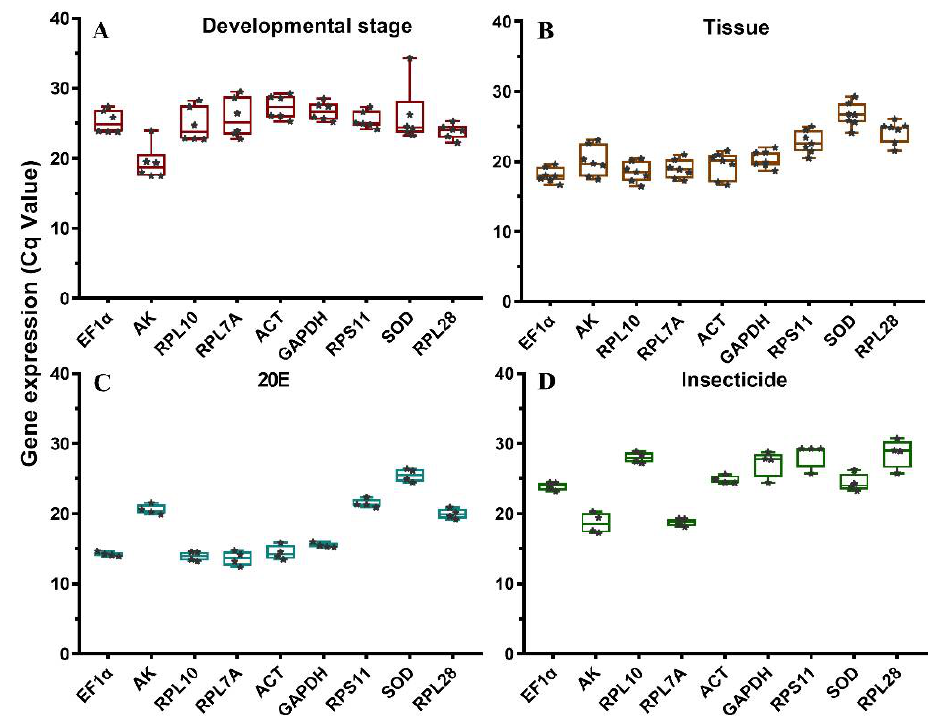
Figure 1. Box and whisker plots of expression profiles of candidate reference genes under four experimental conditions. ( A ) Different developmental stages; ( B ) different tissues; ( C ) 20E treatment; ( D ) insecticide treatments. The expression levels of candidate reference genes are shown as the mean of Ct values. The Ct values of each biological replicate in each treatment is represented as each data points. Lines across the boxes depicted the medians of Cq values, and the 25/75 percentiles were indicated by the lower and upper lines of boxes.